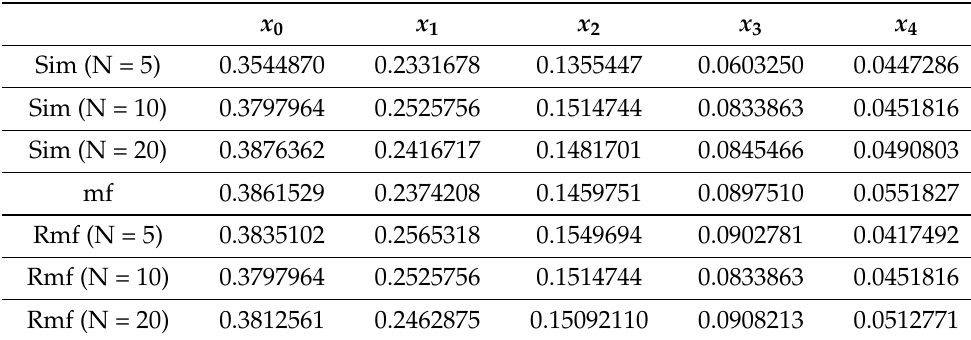
Table 2. Accuracy of mean-field approximation (mf) and refined mean-field approximation (rmf) when N = 5, 10, 20 for x 0 , . . . , x 4 .